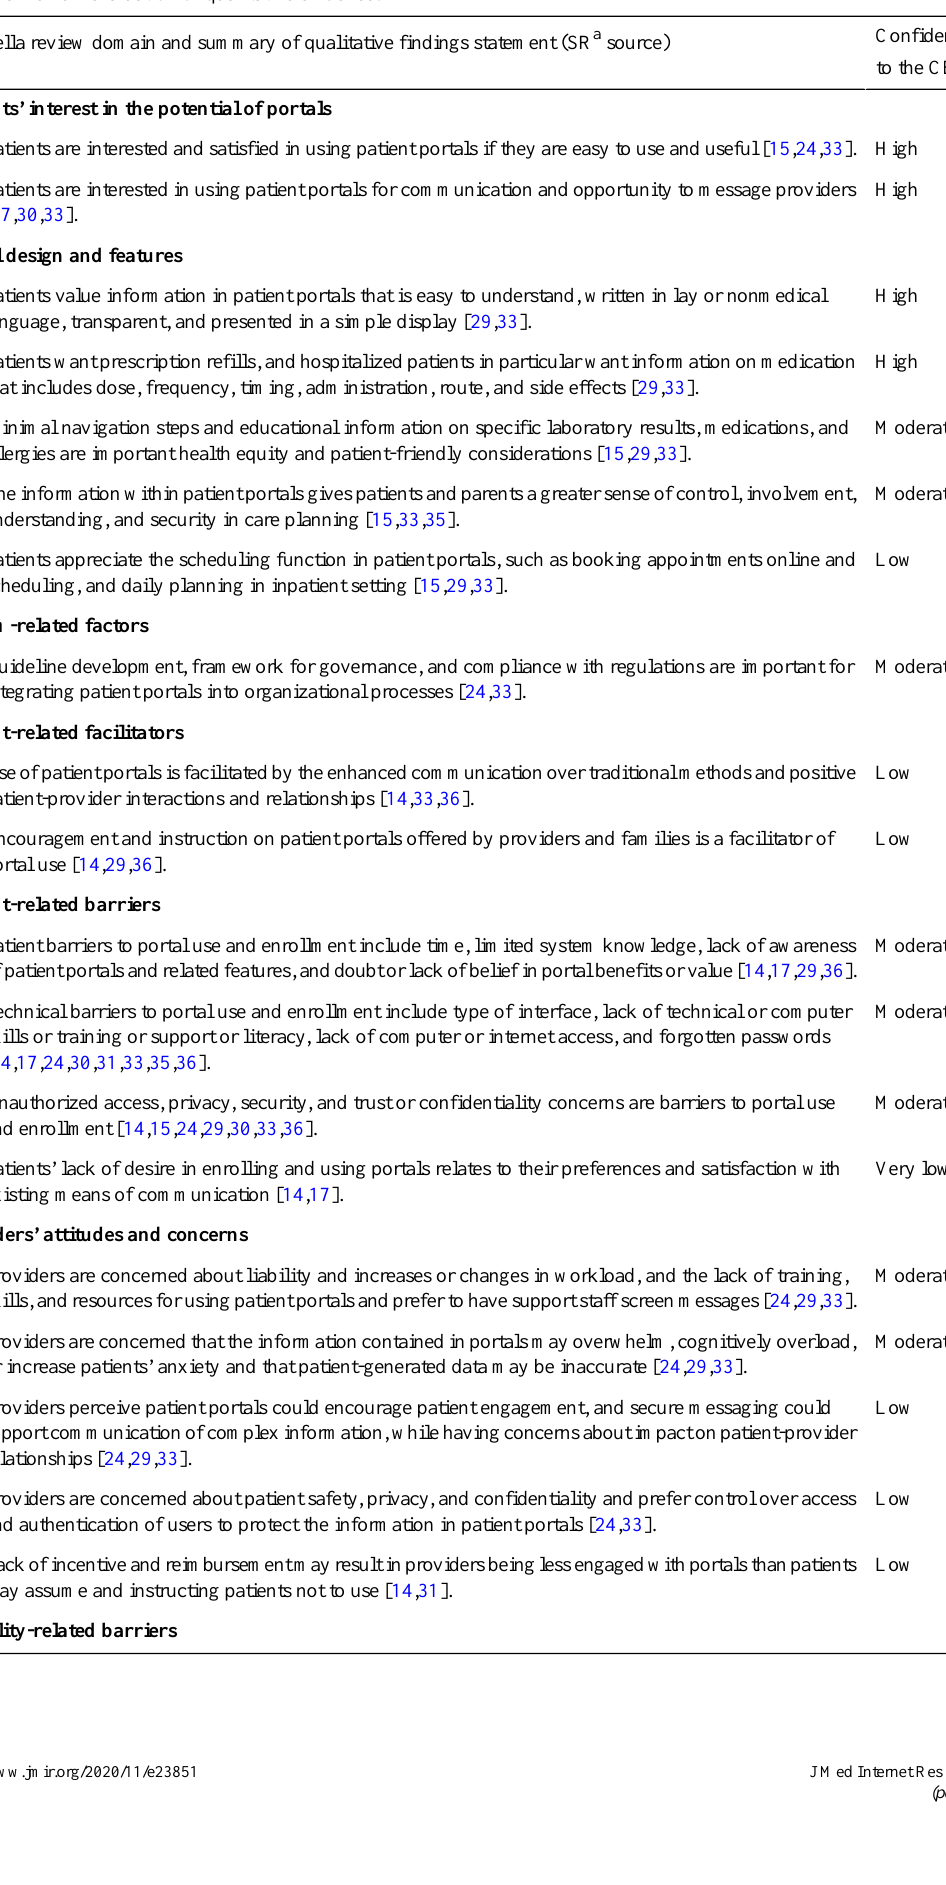
Table 2. Summary of qualitative umbrella review findings and Grading of Confidence in the Evidence of Qualitative Research at the Level of an Umbrella Review evaluation of qualitative